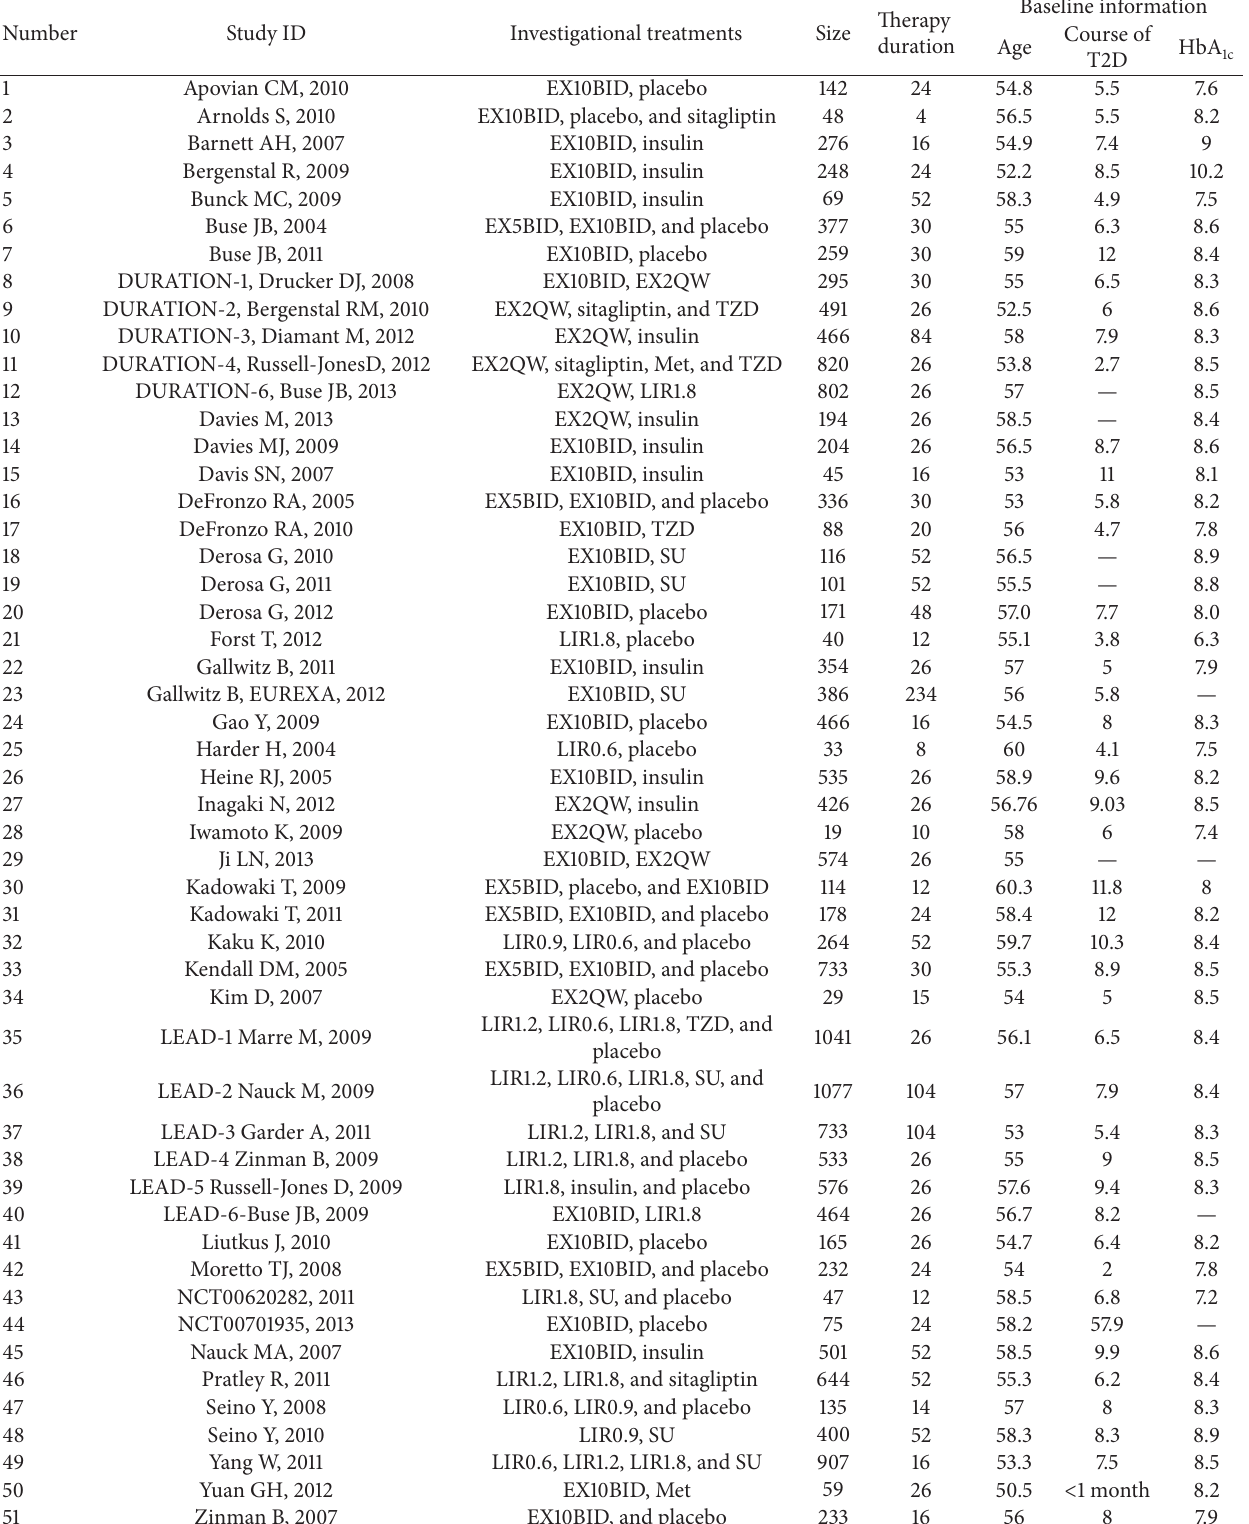
Table 1: Characteristics of the studies included in the network